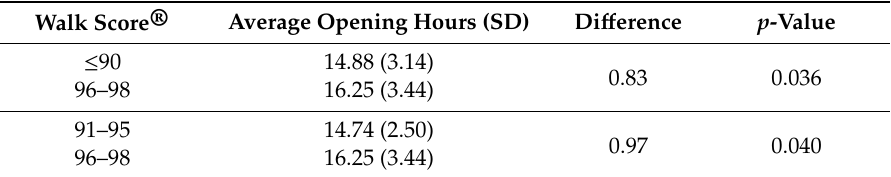
Table 4. Opening hours comparison according to Walk Score ® groups.